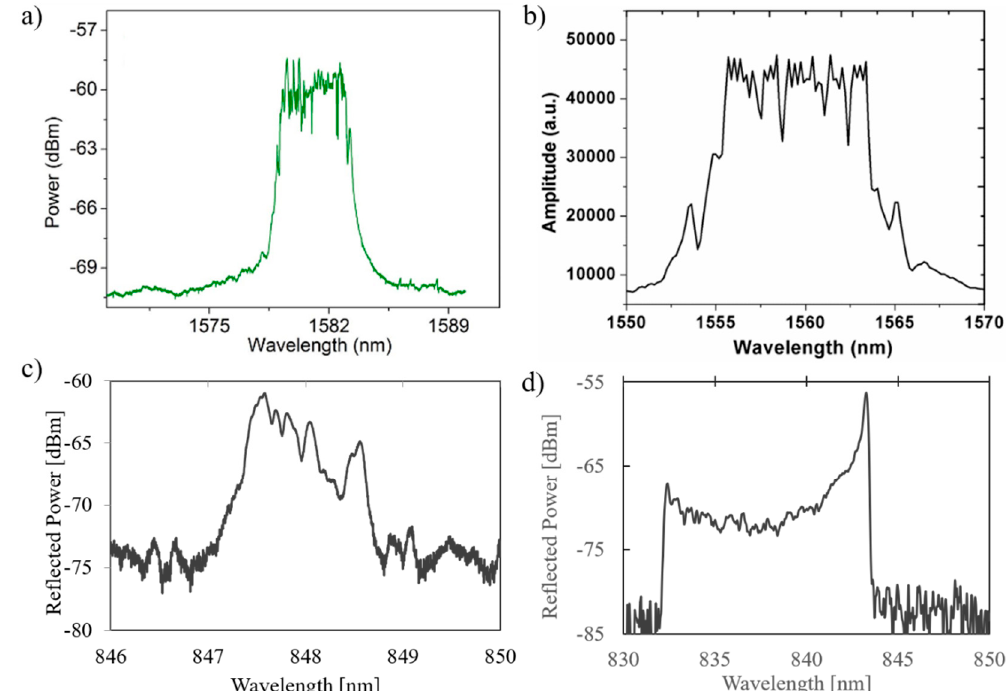
Figure 7. The reflected spectral power of a chirped POFBG fabricated by different techniques: ( a ) chirped phase mask (image adapted from [67]), ( b ) femtosecond directly writing on CYTOP POF (image from [65]), ( c ) under 1.6 % strain with tapering method (image adapted from [109]), and ( d ) thermal annealing (image adapted from [111]).